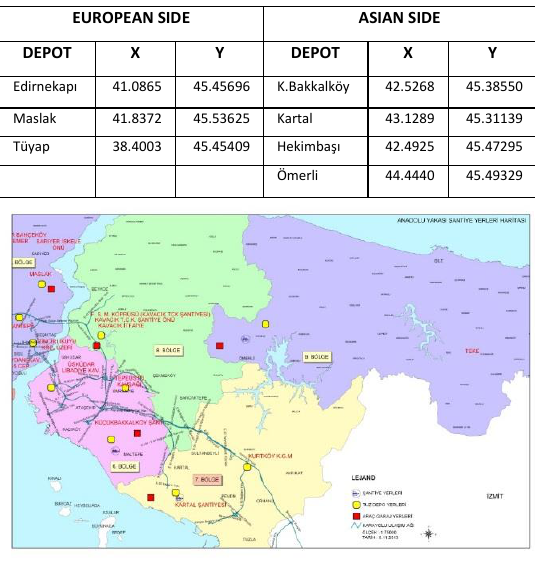
Figure 5: Anatolian Side depots’ locations.